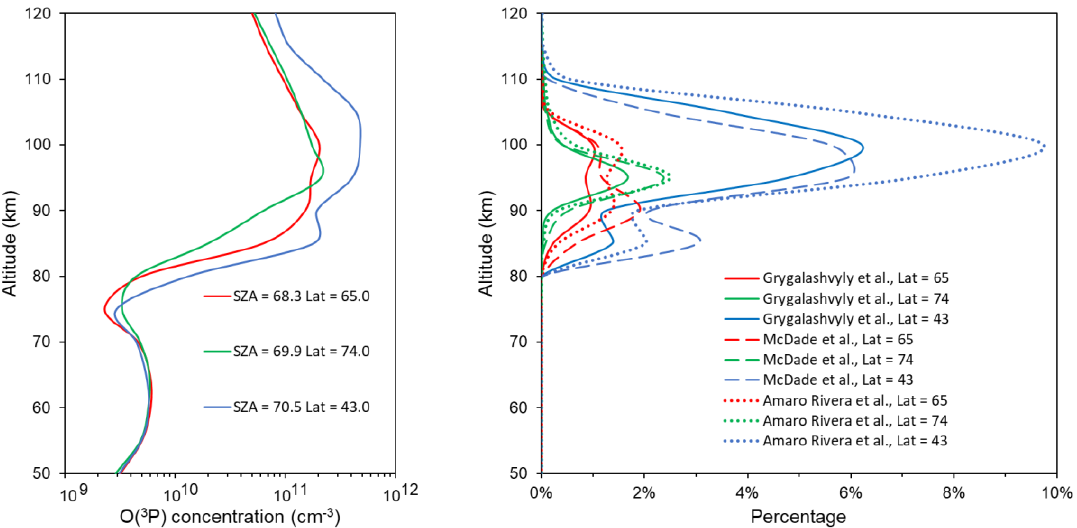
Figure 8. Left panel: altitude profiles of O( 3 P) concentration for di ff erent latitudes from TIMED-SABER data (day 172, year 2010). Right panel: the contribution of the Barth’ mechanism to the O 2 (b 1 Σ g + , v = 0) excitation with respect to the photolytic excitation mechanism of O 2 (b 1 Σ g + , v = 0) in the framework of YM2011 model. Three sets of parametric coe ffi cients for the Barth’ mechanism were used in the calculation (see legend) [15,18,19].